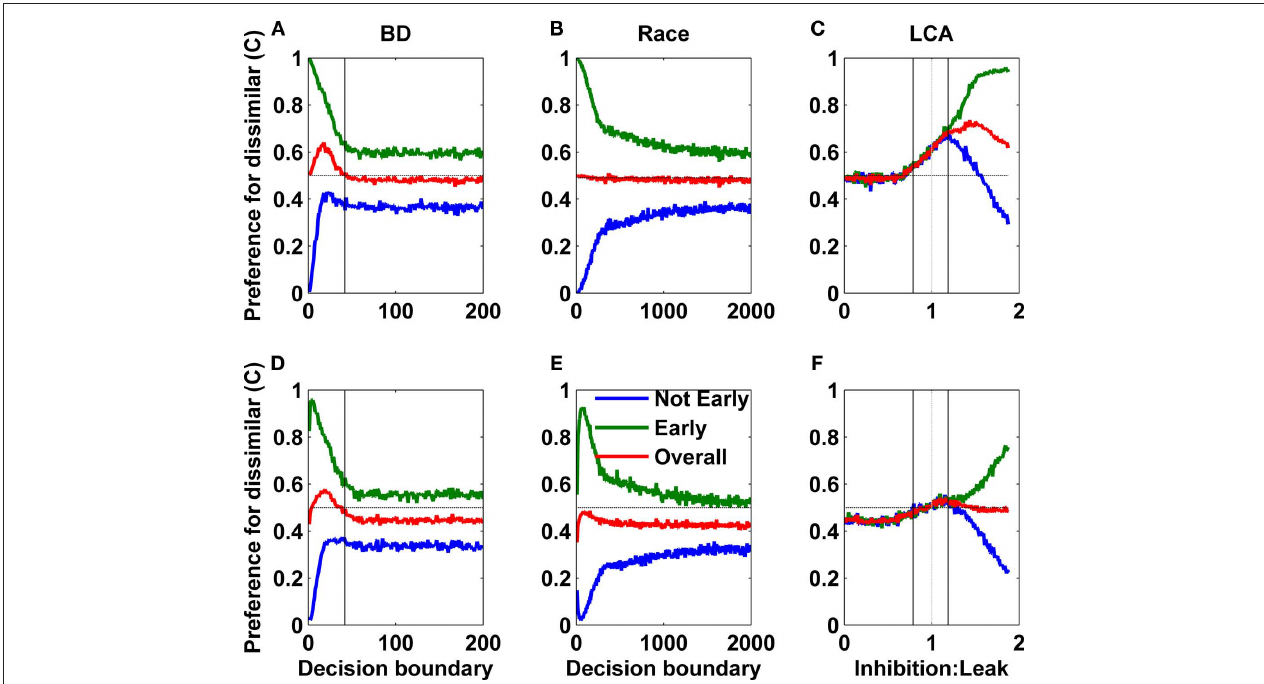
Figure 6 | Predictions for the bounded diffusion and race models and the LCA model with zero ( σ = 0, top) and high ( σ = 0.6, bottom) levels of processing noise. The green curve shows the choice probability for (C) in trials when it is favored at the beginning; blue shows the same when (A,B) are